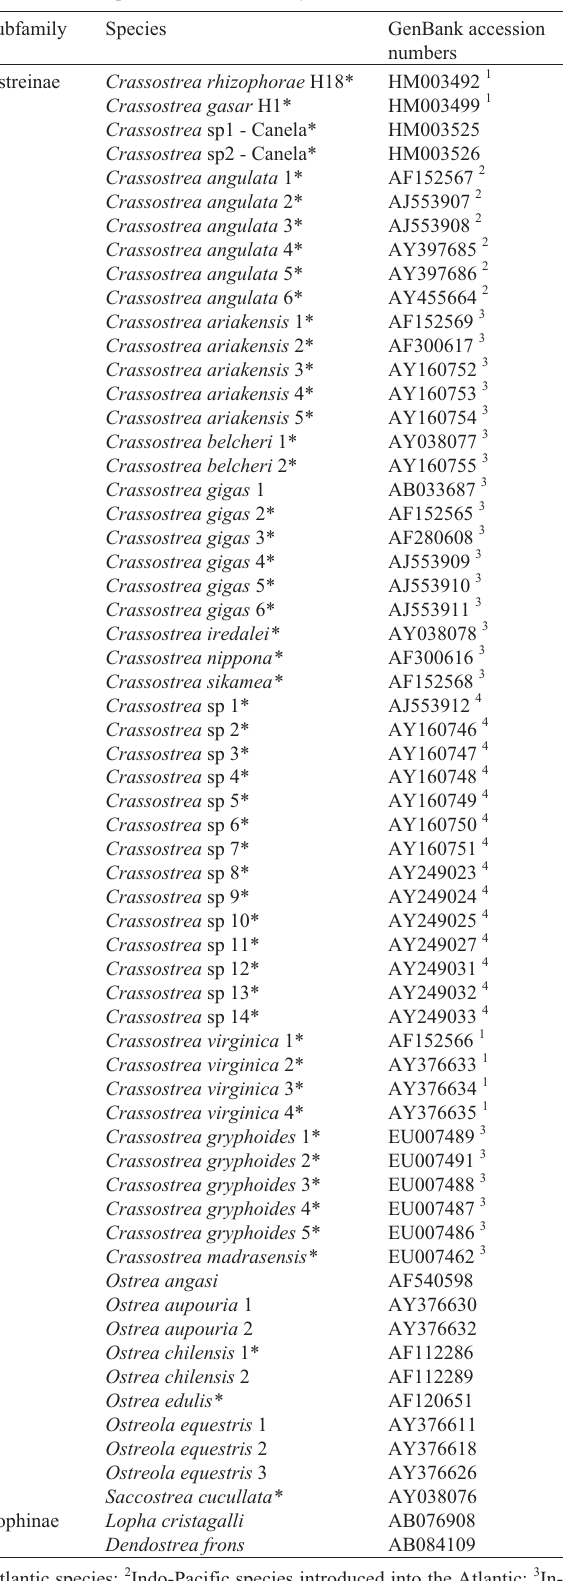
Table 2 - GenBank accession numbers of COI sequences of species of Ostreinae and Lophinae used in the analyses. Subfamily